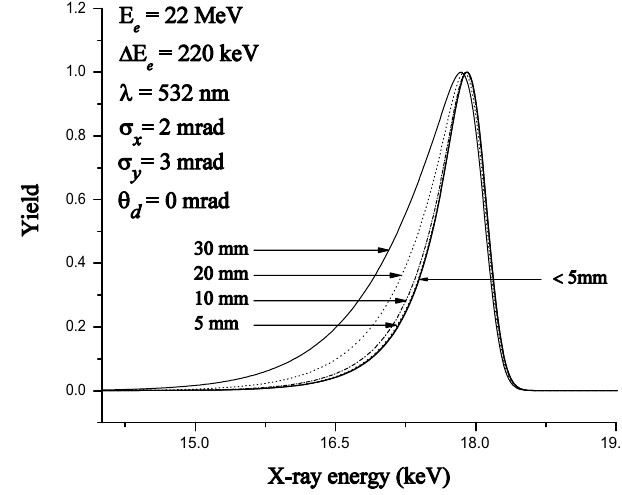
FIG. 3. Variation of amplitude normalized LCS spectrum as a function of the collimator size. The detection angle was equal to 0 mrad and the distance between the interaction point and collimator was equal to 6 m. Simulations show that the shapes of the spectra do not change when the collimator radius is less than 5